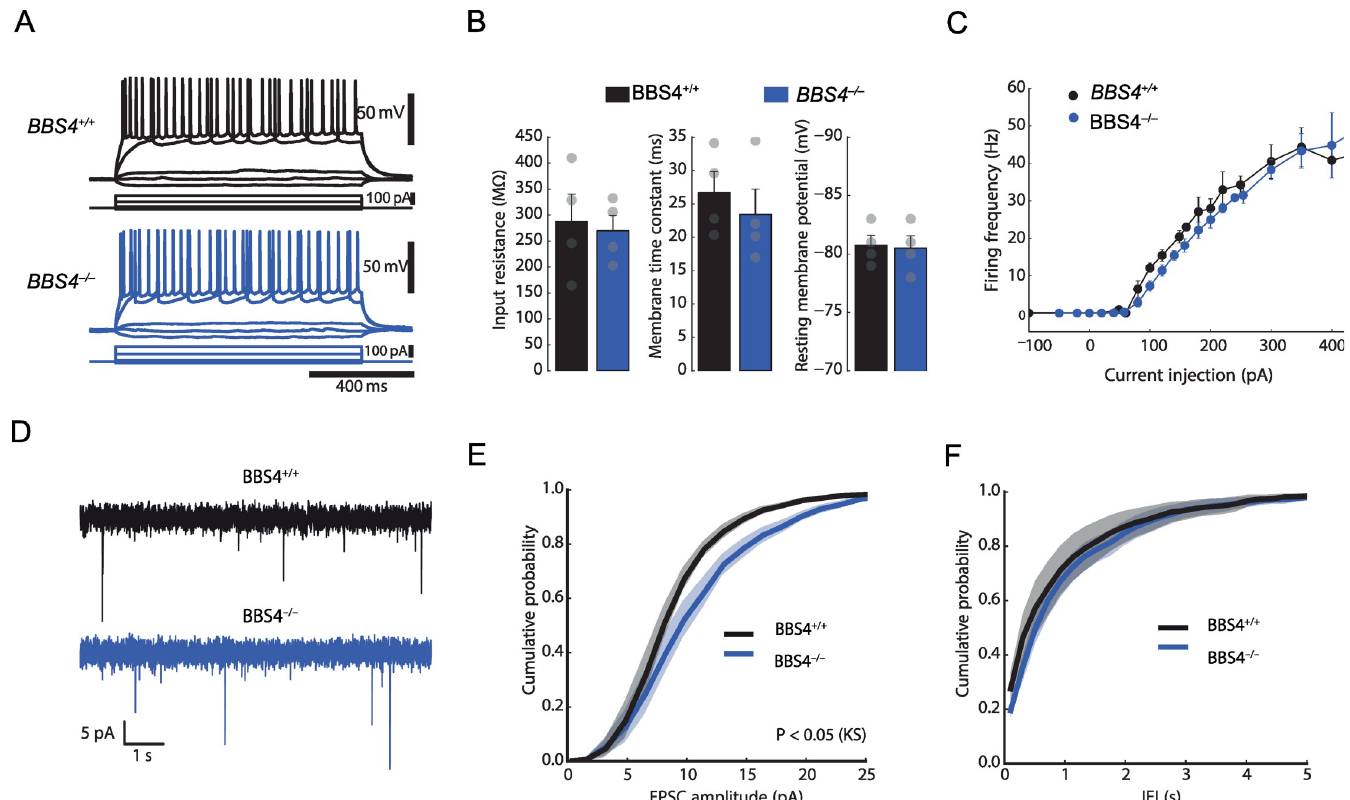
Fig 3. Comparison of electrophysiological properties of hippocampal neurons between Bbs4 −/− and Bbs4 +/+ mice in vitro using acute hippocampal slices. (A) Comparison of firing patterns in response to current injections during current clamp recordings from hippocampal granule cells. (B) Bar graphs summarising passive membrane properties. No significant differences were found between Bbs4 − / − and Bbs4 +/+ mice in input resistance (left), membrane time constant (middle), and resting membrane potential (right). (C) Firing frequency was plotted against current injection amplitudes. No significant differences were found between Bbs4 − / − and Bbs4 +/+ mice. (D) mEPSCs were recorded from hippocampal granule cells in Bbs4 − / − and Bbs4 +/+ mice ( N = 6). (E) Cumulative probability plot comparing mEPSC amplitudes between Bbs4 − / − and Bbs4 +/+ mice. mEPSC amplitudes in granule cells of Bbs4 − / − mice are significantly larger ( N = 6, P < 0.05, Kolmogorov-Smirnov test). (F) Cumulative probability plot comparing inter-event intervals (IEIs) of mEPSCs between Bbs4 − / − and Bbs4 +/+ mice ( N = 6; P = 0.27, Kolmogorov-Smirnov test). Underlying data are available in S3 Data. Bbs4 , Bardet-Biedl syndrome 4; IEI, inter-event interval; KS, Kolmogorov-Smirnov; mEPSC, miniature excitatory postsynaptic current.